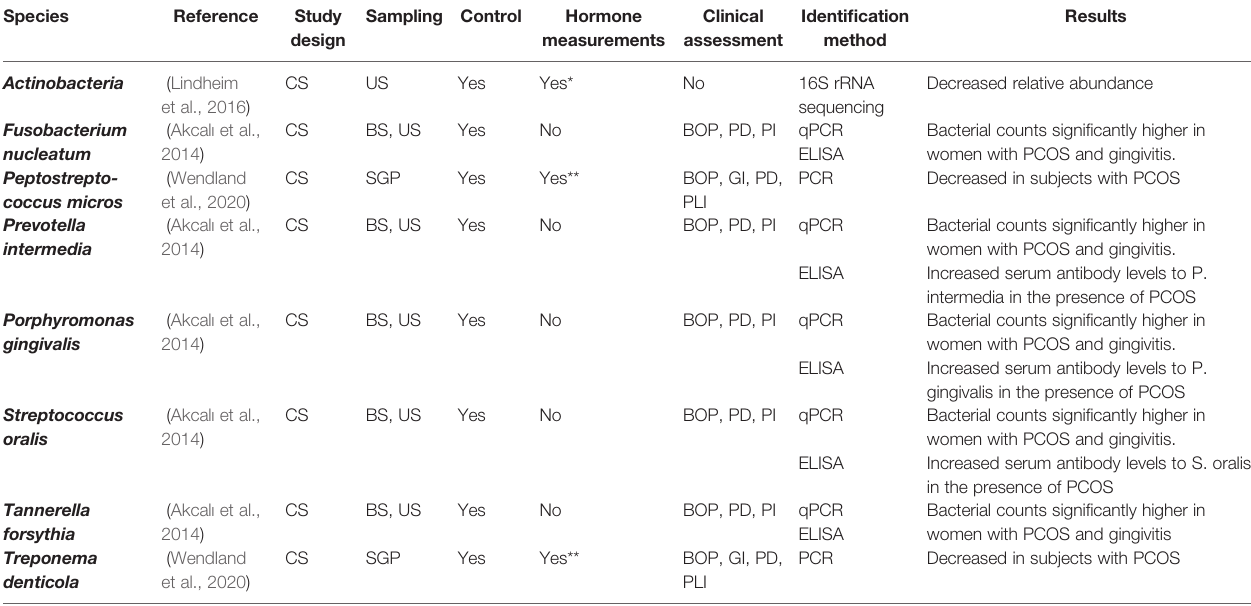
TABLE 3 | Bacteria and fungi affected by polycystic ovary syndrome (PCOS).